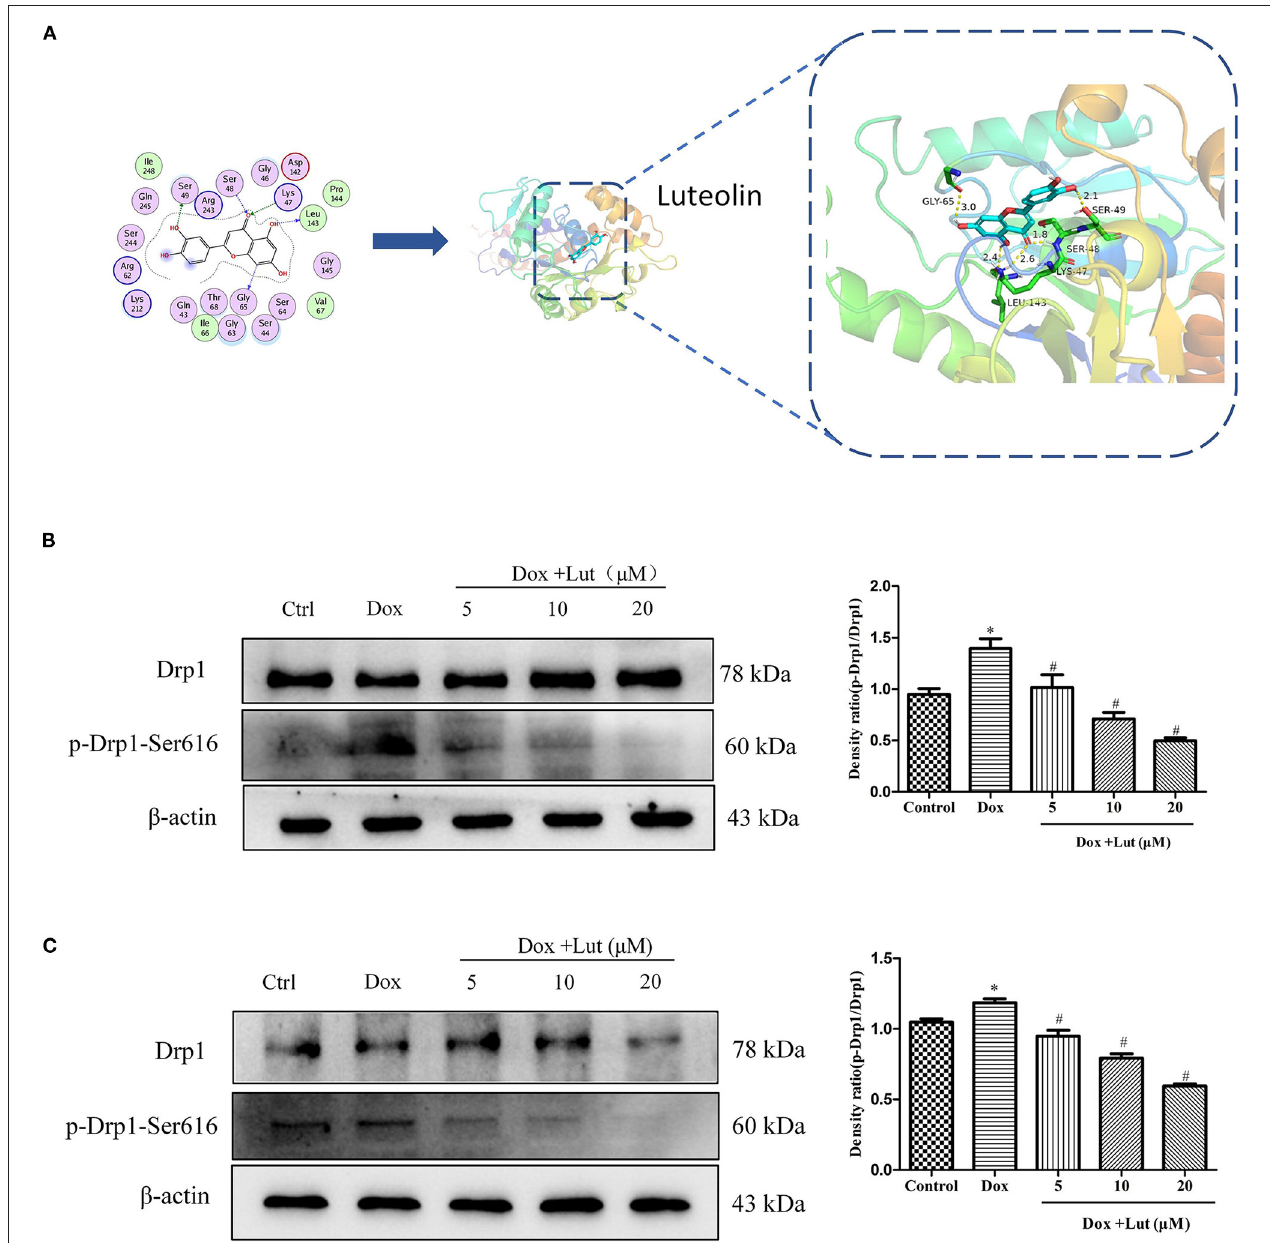
FIGURE 5 | Lut attenuated Dox-induced Drp-1 phosphorylation in H9c2 and AC16 cells. (A) Detailed molecular docking simulations. The blue circle on the left represents the binding site of the small-molecule compound, and the bar graph on the right describes the specific form of this interaction. Representative Western blot images of Drp-1 and p-Drp-1 in H9c2 (B) and AC16 (C) cells. Mean ± SD, n = 3 independent experiment. * P < 0.05 compared with control group. # P < 0.05 compared with Dox